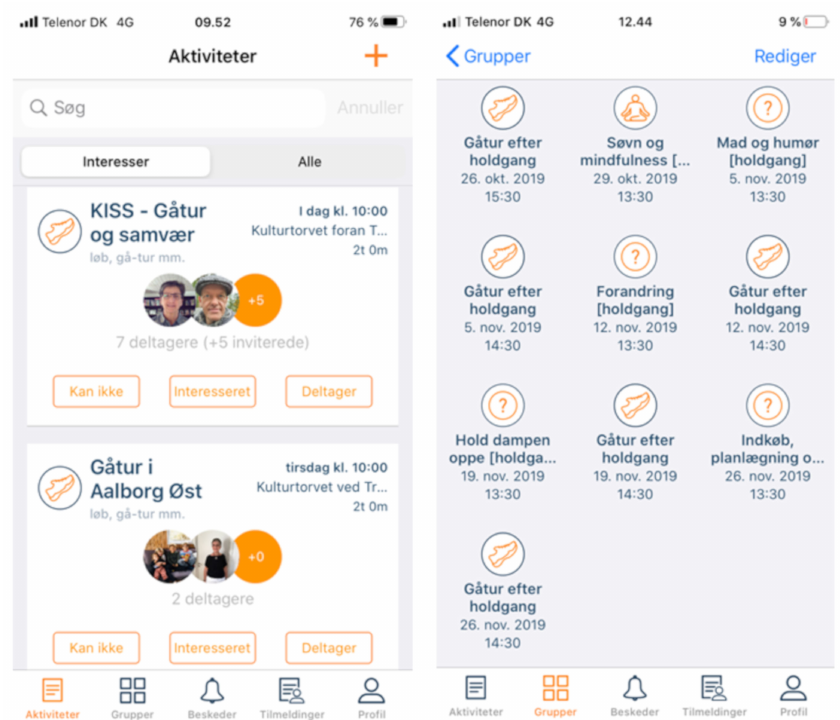
Figure 2. Left: Two activities posted by the facilitator of Pilot A with visualization of members who have signed up for the activity. Right: Activities posted by the facilitator in the Pilot A